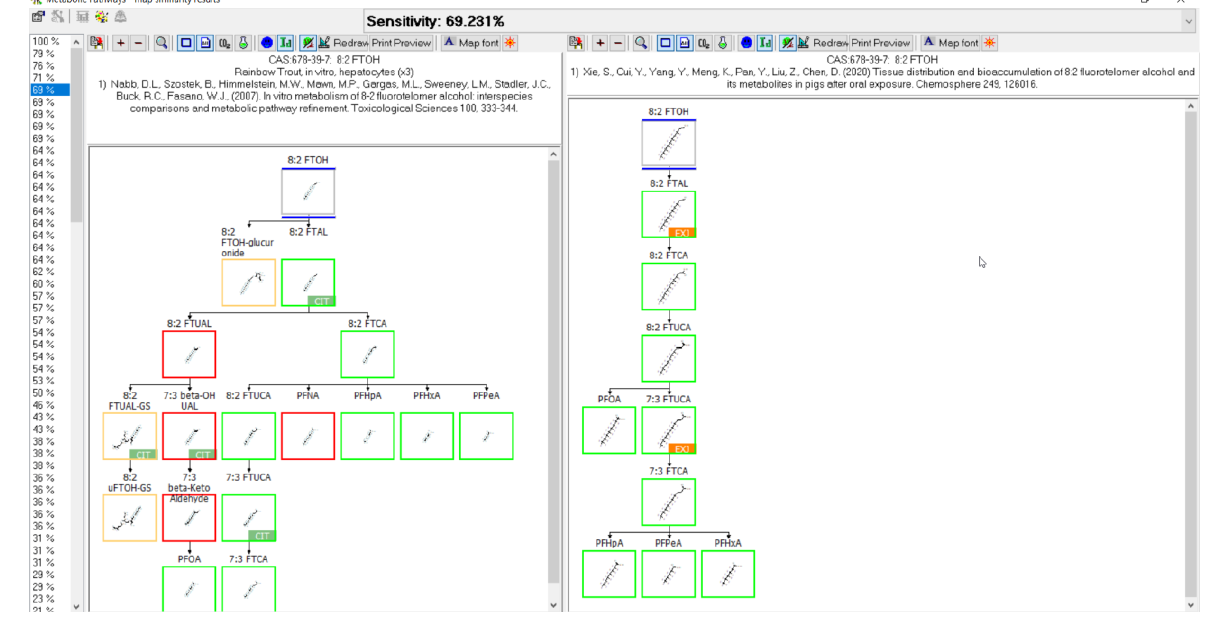
Figure 17. Metabolic map comparison of 8:2 FTOH in ( left ) rainbow trout hepatocytes and ( right ) in vivo rat. Metabolites common to both species are indicated by green boxes. Differences in metab- olites are indicated by red boxes. Tan boxes indicate phase II conjugates. Sensitivity, in this case 69.231%, is an assessment of the map comparison whereby the number of common metabolites is divided by the total number of metabolites in the fish map. Metabolites labeled with CIT are pre- sumed intermediates in the path but were not identified in the study.